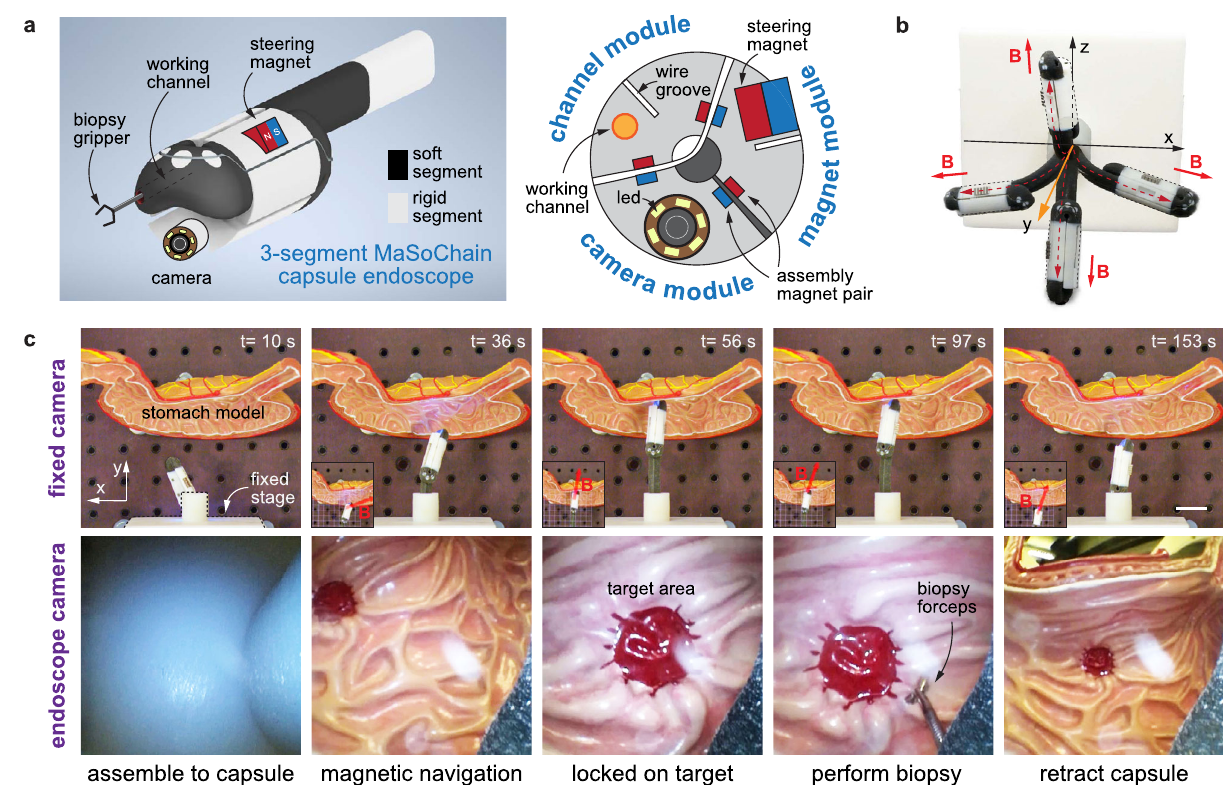
Fig. 9 | Self-folded tethered capsule endoscope made by three-segment MaSoChain. a Structural design of a foldable endoscope with 3 functional seg- ments: the camera module, the magnet module with a large steering magnet and the channel module through which a biopsy gripper can pass. The three-segment MaSoChain structure can self-assemble into a capsule endoscope when pushing out the tube. b The tethered capsule endoscope can be actively steered using an external magnetic fi eld. The capsule position and orientation are shown with